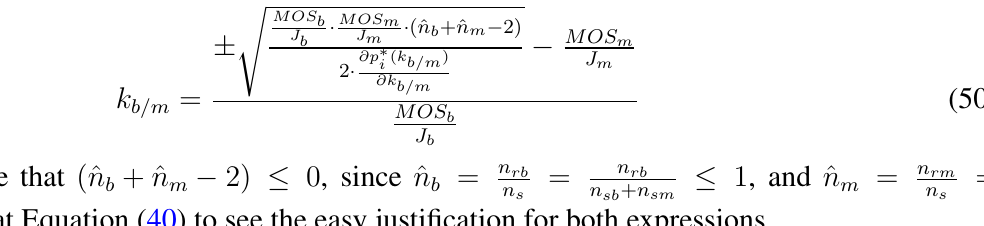
, see Equation b/m